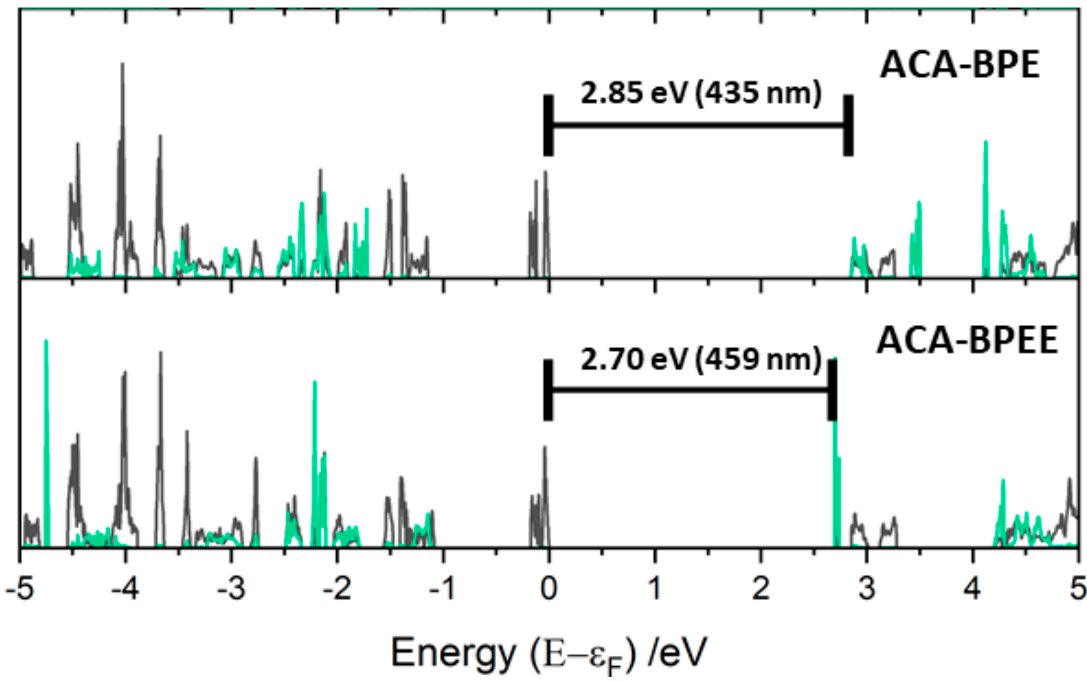
Figure 6. Electronic density of states (DoS) calculated for the ACA-based cocrystals, calculated at the HSE06 level of the theory. For each cocrystal, the projected DoS are shown for ACA (black) and the conformer molecules (green). The band gap is marked in each case.